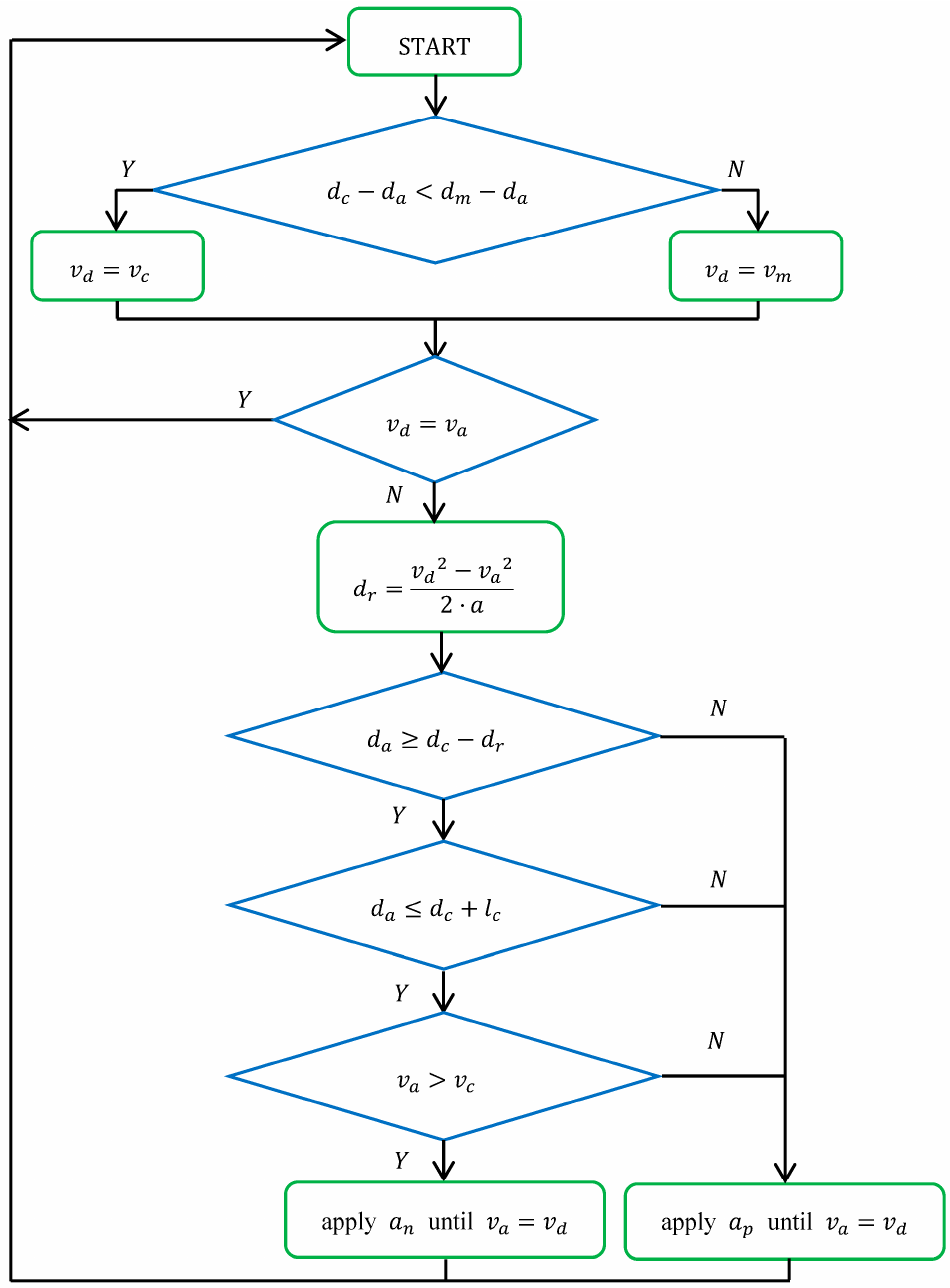
Figure 4. Speed planning algorithm.